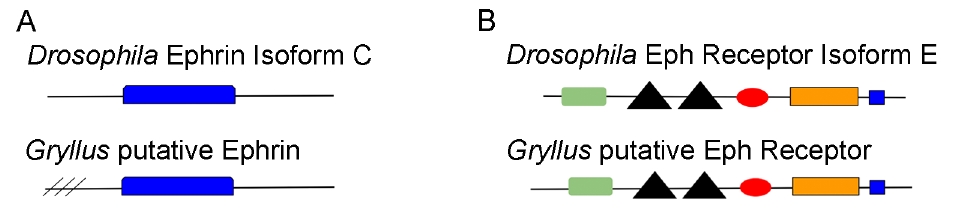
Fig 4. Ephrin and Eph proteins in Drosophila and those predicted in G . bimaculatus are identical in domain type, number and organization. The type, number, and order of protein domains was assessed by using Drosophila Ephrin Isoform C (AAN06500) and the putative G . bimaculatus Ephrin (TRINITY_DN159904_c0_g1_i6) as queries in a conserved domain search. In both proteins, an Ephrin domain was present (blue rectangle). Angled lines indicate incomplete G . bimaculatus sequence at the N-terminal end. B) The type, number, and order of protein domains in Drosophila Eph (AAN06503) and putative G . bimaculatus Eph (TRINITY_DN159184_c0_g1_i3) was determined. Both proteins showed identical number, order, and type of domain, which included an eph receptor ligand binding domain (green rectangle), two fibronectin type 3 domains (triangles), an ephrin type A receptor 2 transmembrane domain (red oval), an ephrin receptor protein tyrosine kinase domain (orange rectangle), and a SAM domain (blue square).